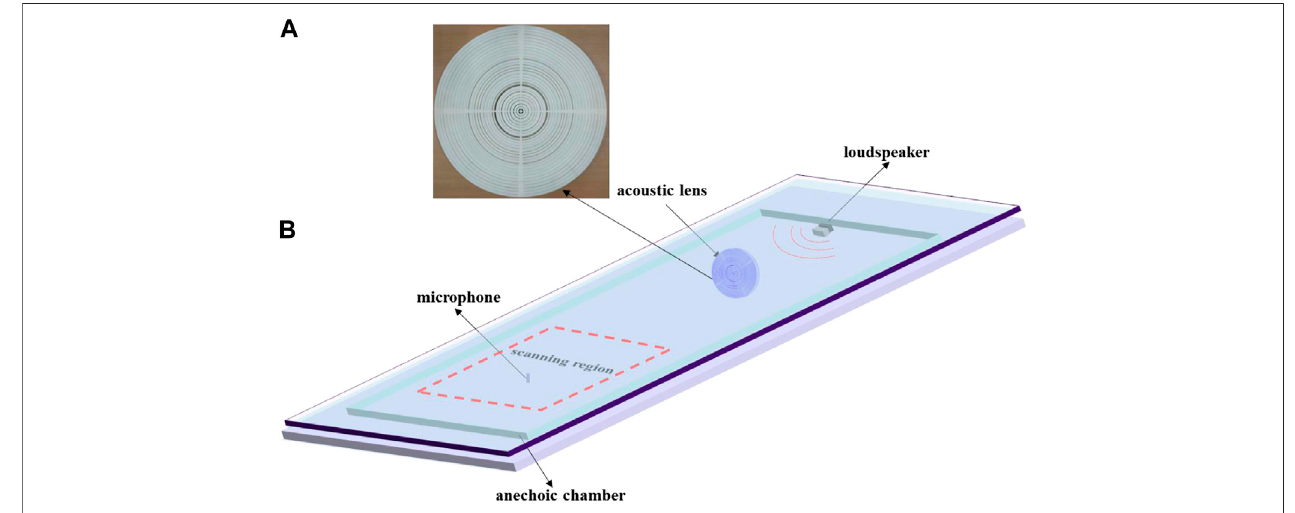
FIGURE2| Experimentalsamplesoftheacousticmeta-lensandtheexperimentalsetups. (A) Schematicrepresentationofthetwo-dimensionalfabricatedlens. (B) Schematic representation of the experimental setup. The acoustic experiments are conducted in an anechoic chamber. The loudspeaker is used as the source, and a microphone is used to sweep the measured area by using a 3D stepping motor and record the distributions of sound pressure around the acoustic meta-lens.